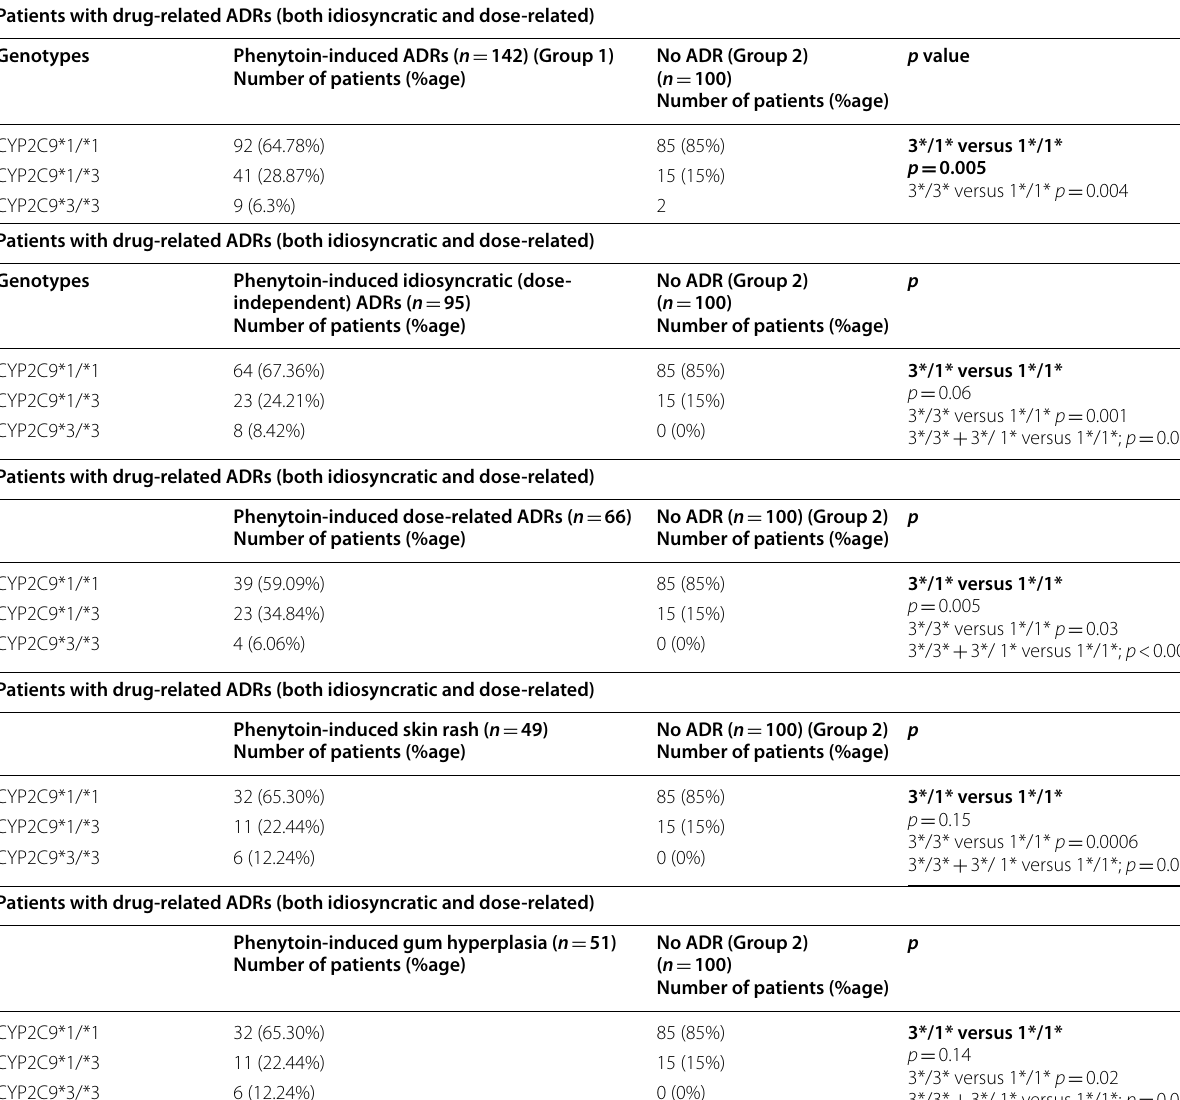
glucuronidated by UGT1A1, while R isomer is preferen- tially glucuronidated by UGT1A9 and UGT2B15. Under normal circumstances, 90% of PHT is metabolized by CYP2C9 and 10% is metabolized by CYP2C19 [9,14,19]. lism of PHT. Specifically, the presence of CYP2C9*2 (transition C > T at position 432 of exon 3 resulting in replacement of arginine by cysteine at position 144 of at position 1077 of exon 7 resulting in replacement of isoleucine by leucine at position 359 of CYP2C9 pro-